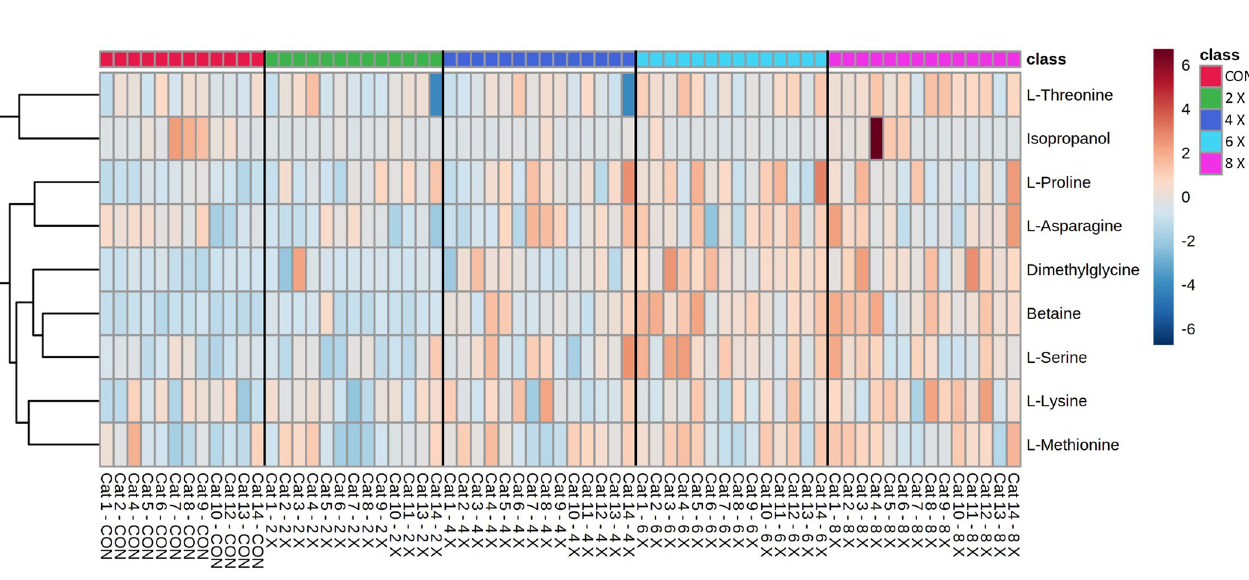
Fig 1. Heatmap with euclidean distance and ward clustering of mean serum metabolites determined by quantitative NMR spectroscopy in overweight cats (n = 14) receiving control (no additional choline supplementation, 1.2 x NRC RA, 77 mg/kg BW0.67), choline at 2 x NRC RA (126 mg/kg BW0.67), 4 x NRC RA (252 mg/kg BW0.67), 6 x NRC RA (378 mg/kg BW0.67), and 8 x NRC RA (504 mg/kg BW0.67), in a 5 x 5 Latin square design for 3-week periods, with a significant effect of choline dose (P <